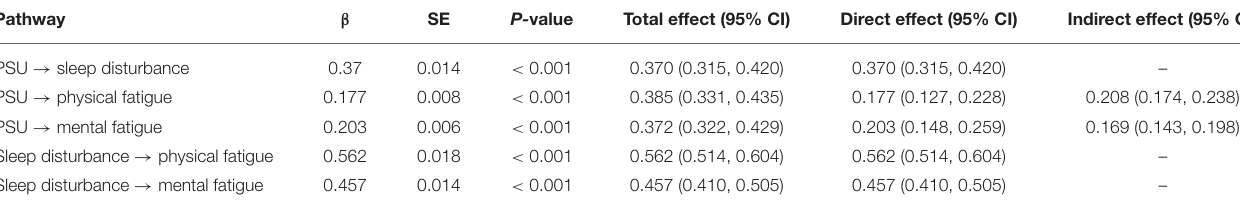
TABLE 4 | Path coefficients and effect values of PSU on sleep disturbance, physical fatigue, and mental fatigue.